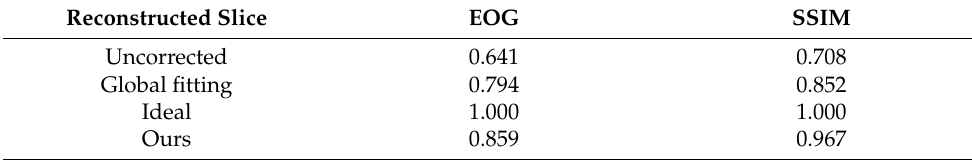
Figure 6. The slices and profiles corrected via different methods. ( a ) The uncorrected slice; ( b ) slice corrected by global fitting; ( c ) ideal slice; ( d ) the slice corrected by the proposed method; ( e ) the slice profile at row 274; ( f ) the slice profile in the 300th column. Table 4. EOG and SSIM in Figure 6a–d.